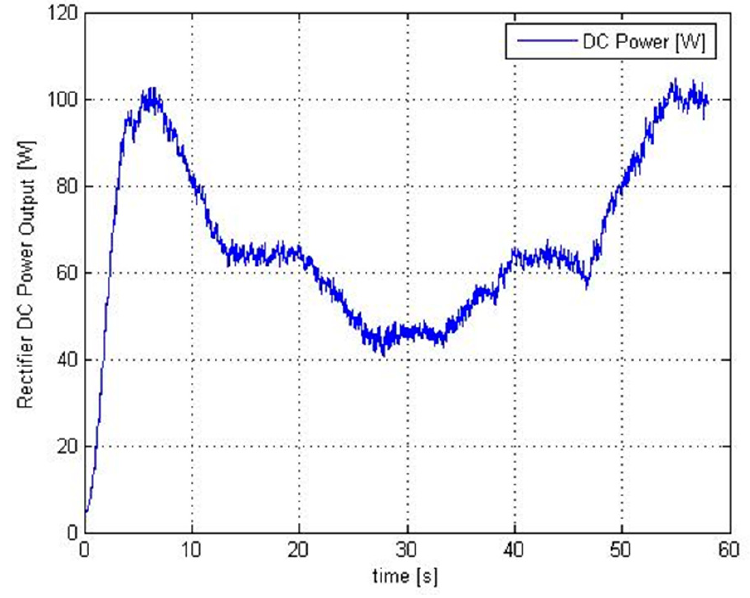
Figure 8. Rectifier DC power output.